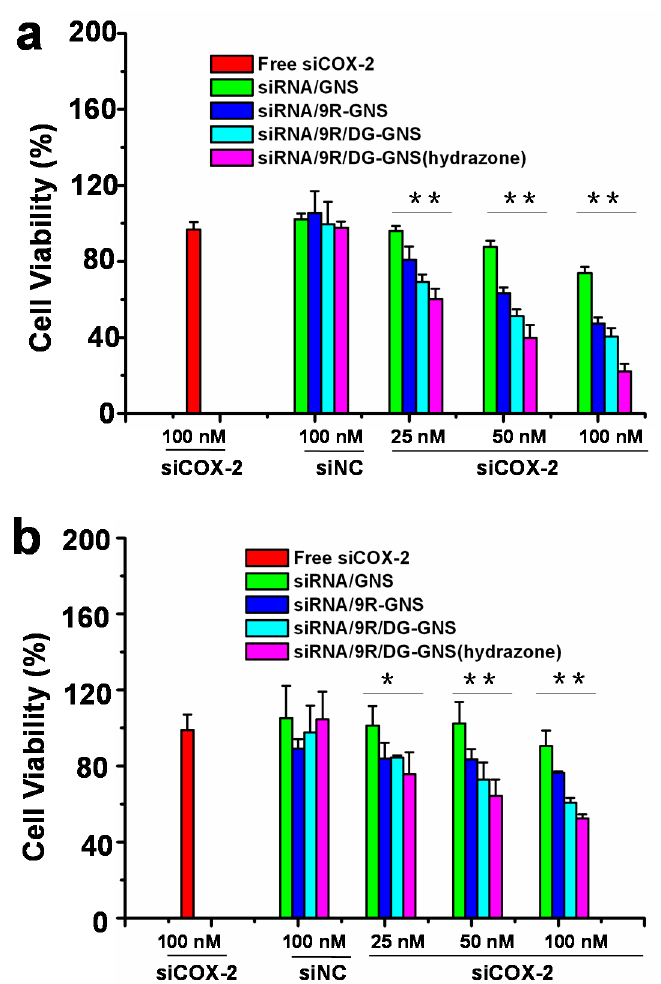
Figure 7. Cell viabilities of HepG2 ( a ) and SGC7901 ( b ) cells after transfected with 100 nM of siCOX-2, 25, 50 and 100 nM of siCOX-2 loaded GNS, 9R-GNS, 9R/DG-GNS, 9R/DG-GNS (hydrazone), or 100 nM of siNC loaded 9R/DG-GNS (hydrazone). Data represent mean ± SD ( n = 4). * p < 0.05, ** p < 0.01.